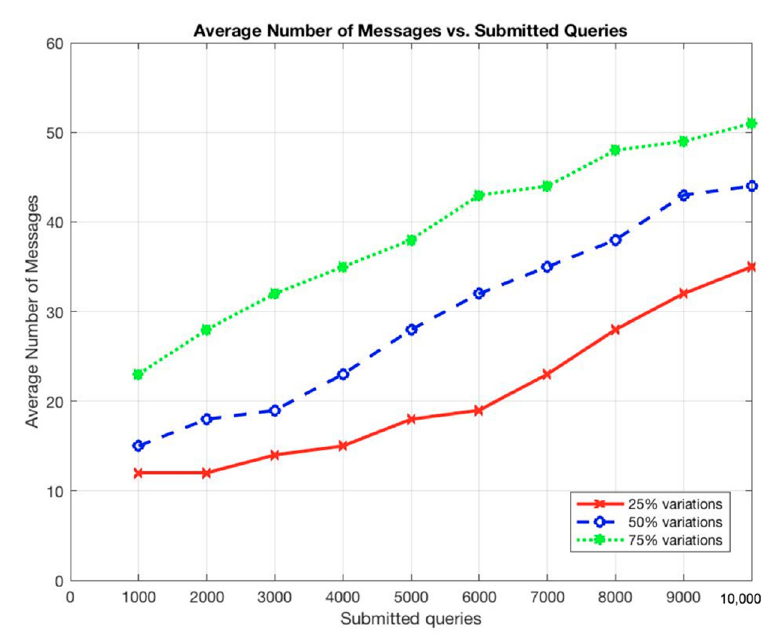
Figure 8. Average number of messages vs. submitted queries.